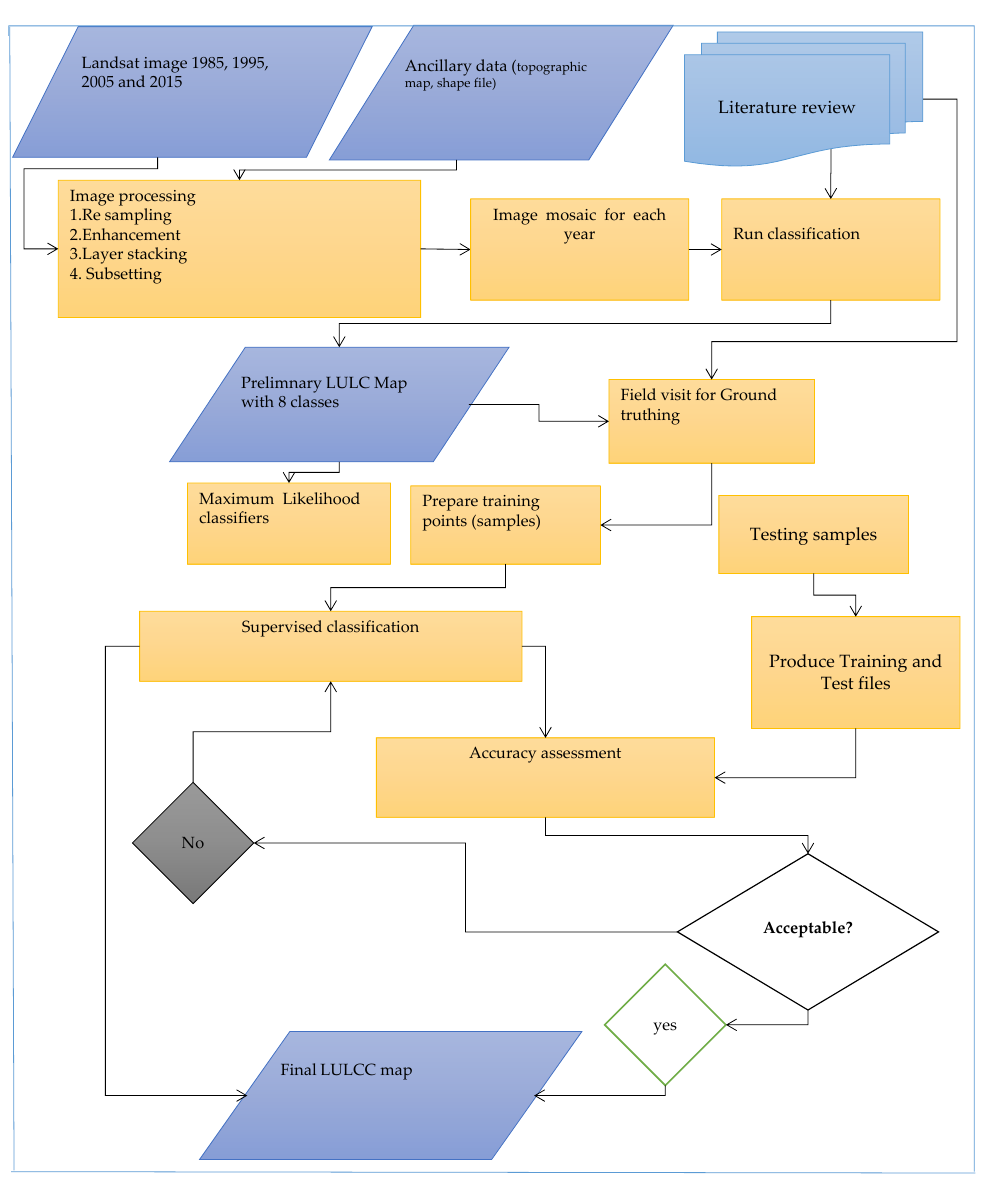
Figure 2. Flowchart showing the procedures employed to arrive at the final LULCC